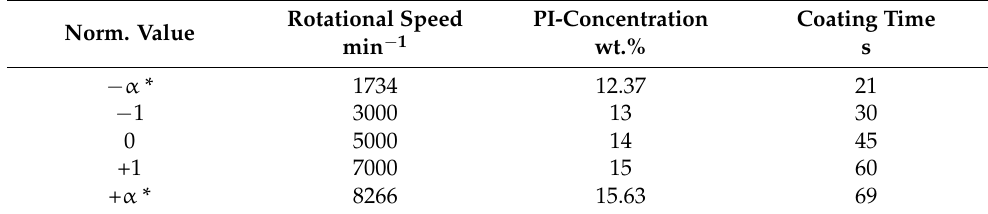
Table 6. Parameters for study on coating of PI-based dispersions. Norm. Value